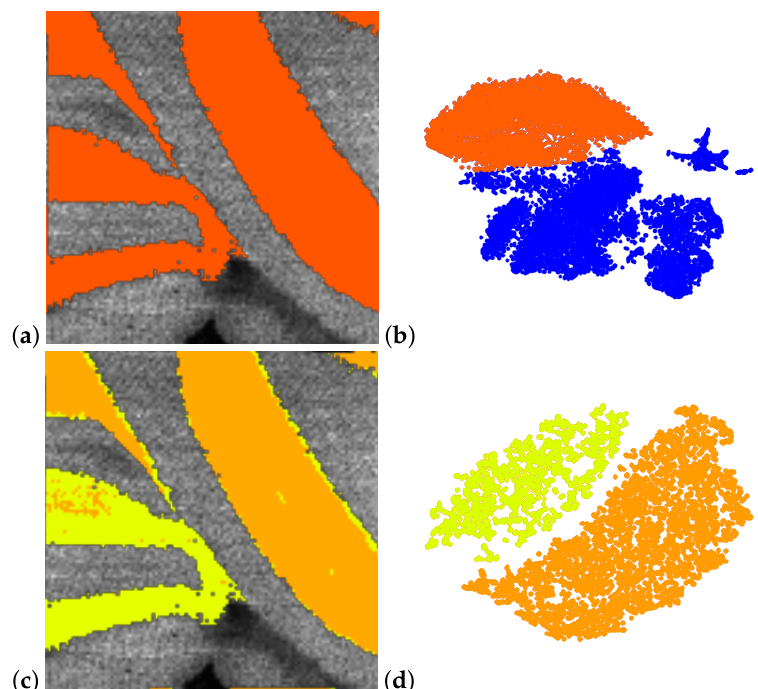
Figure 3. Sub-population selection in non-linear embedding ( b ) for further analysis in a re-configured non-linear embedding ( d ) allows refinement of clusters. Respective image regions are highlighted in the coordinated image-space views ( a , c ). Methodology applied to mouse cerebellum in negative ion mode data set